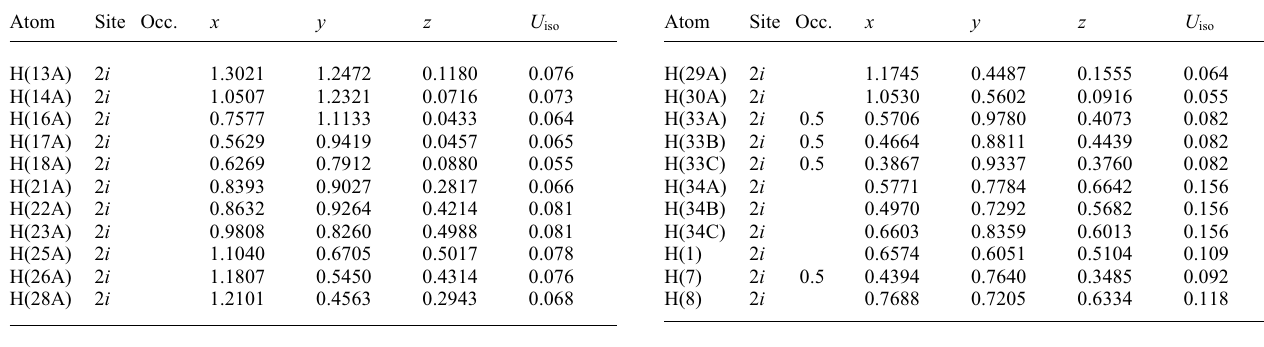
Table 3. Atomic coordinates and displacement parameters (in Å 2 ). Atom Site